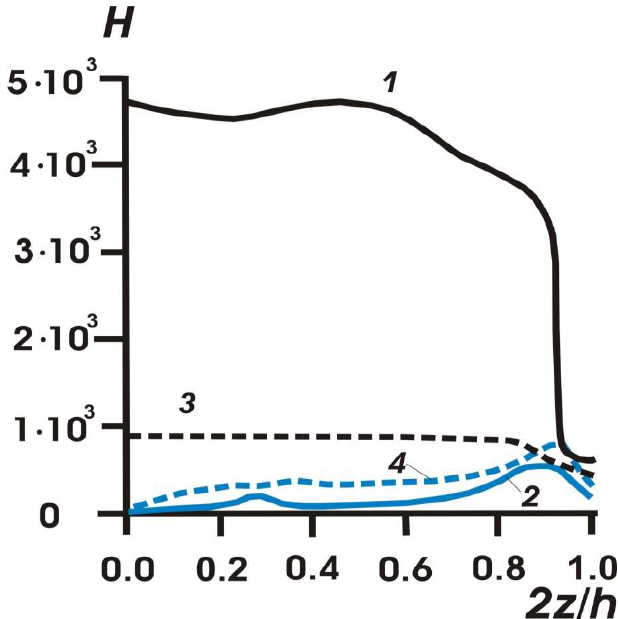
Fig. 3. The components of the magnetic field (A/m) in NSR at a current of 10 A in dependence on the coordinate along the axis. Curves 1 and 2: H z and H ρ with ρ = 0; curves 3 and 4: - H z and H ρ with ρ/R 2 =